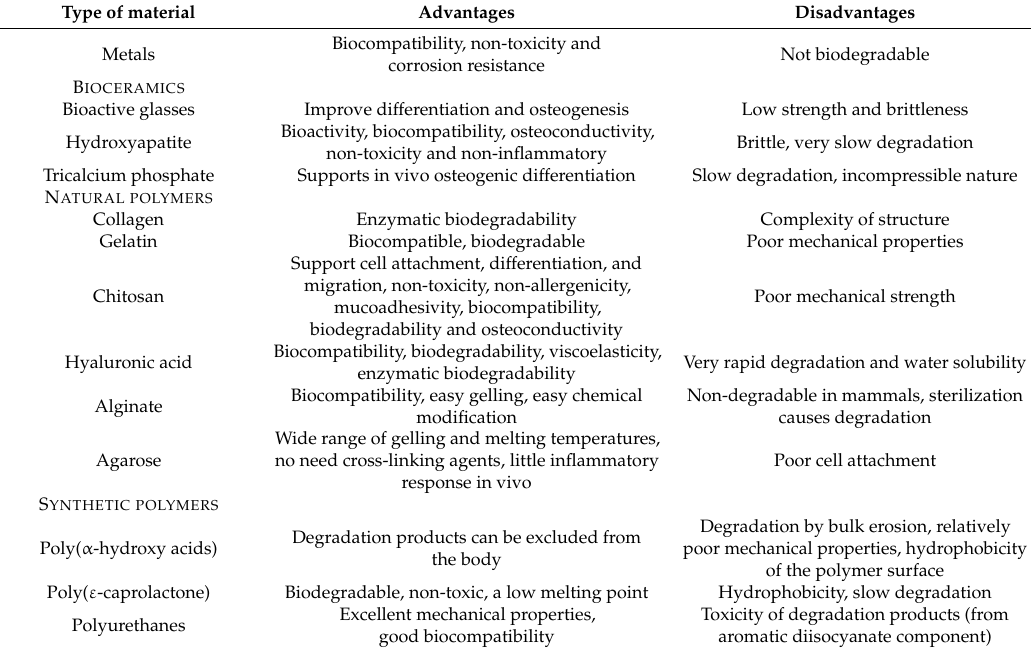
Table 3. Types of materials used in tissue engineering and their advantages and